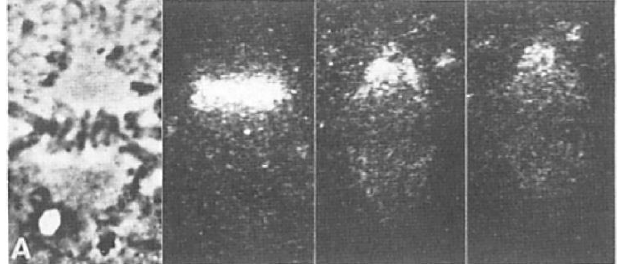
Figure 21. Phase-contrast and three fluorescence images of the cell to be analyzed. Times relative to photoactivation are (from left to right): 418, 5, 429, 674 s. Pole to pole distance = 18.8 µm. From Mitchison, 1989 [157]. This image is displayed under the terms of a Creative Commons License (Attribution-Noncommercial-Share Alike 3.0 Unported license, as described at http://creativecommons.org/licenses/by-nc-sa/3.0/.